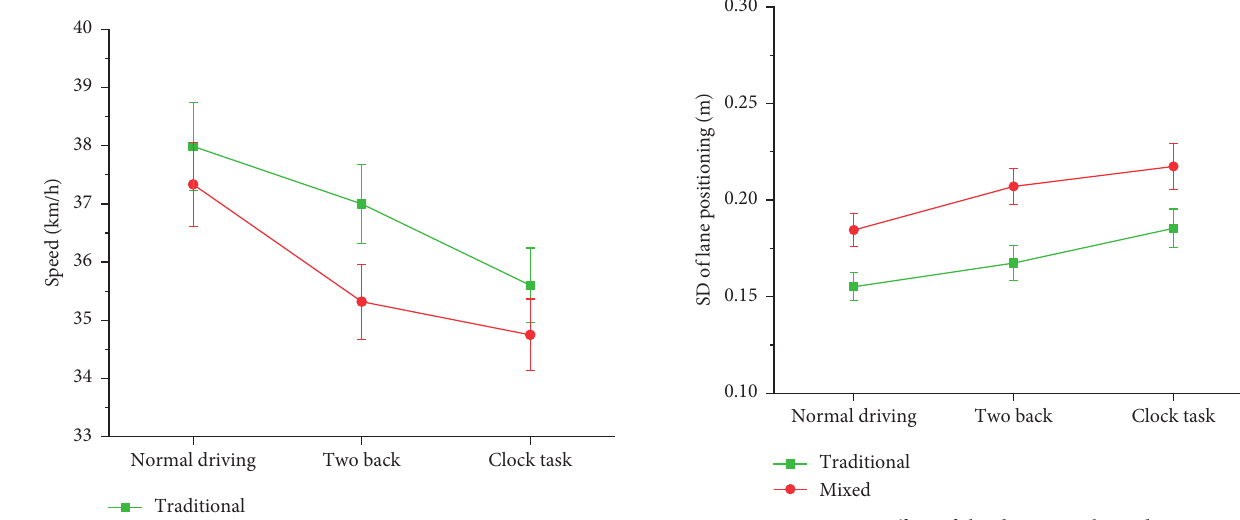
Figure 14: Interaction effect of the driving tasks and environment on the